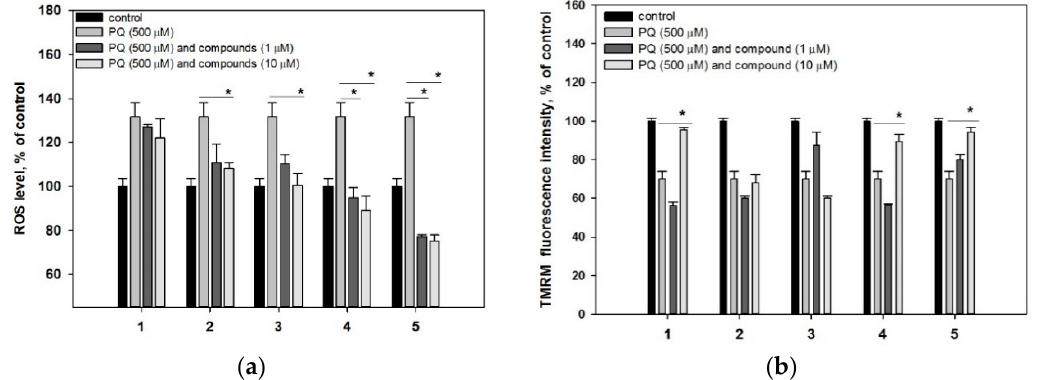
Figure 3. Effects of compounds 1 – 5 on ROS level ( a ) and MMP ( b ) in Neuro-2a cells after 1 h of treatment with PQ. Each bar represents the mean ± SEM of three independent replicates. (*) indicates p < 0.05 versus PQ-treated cells. The difference between control and PQ-treated cells was considered significant ( p < 0.05).